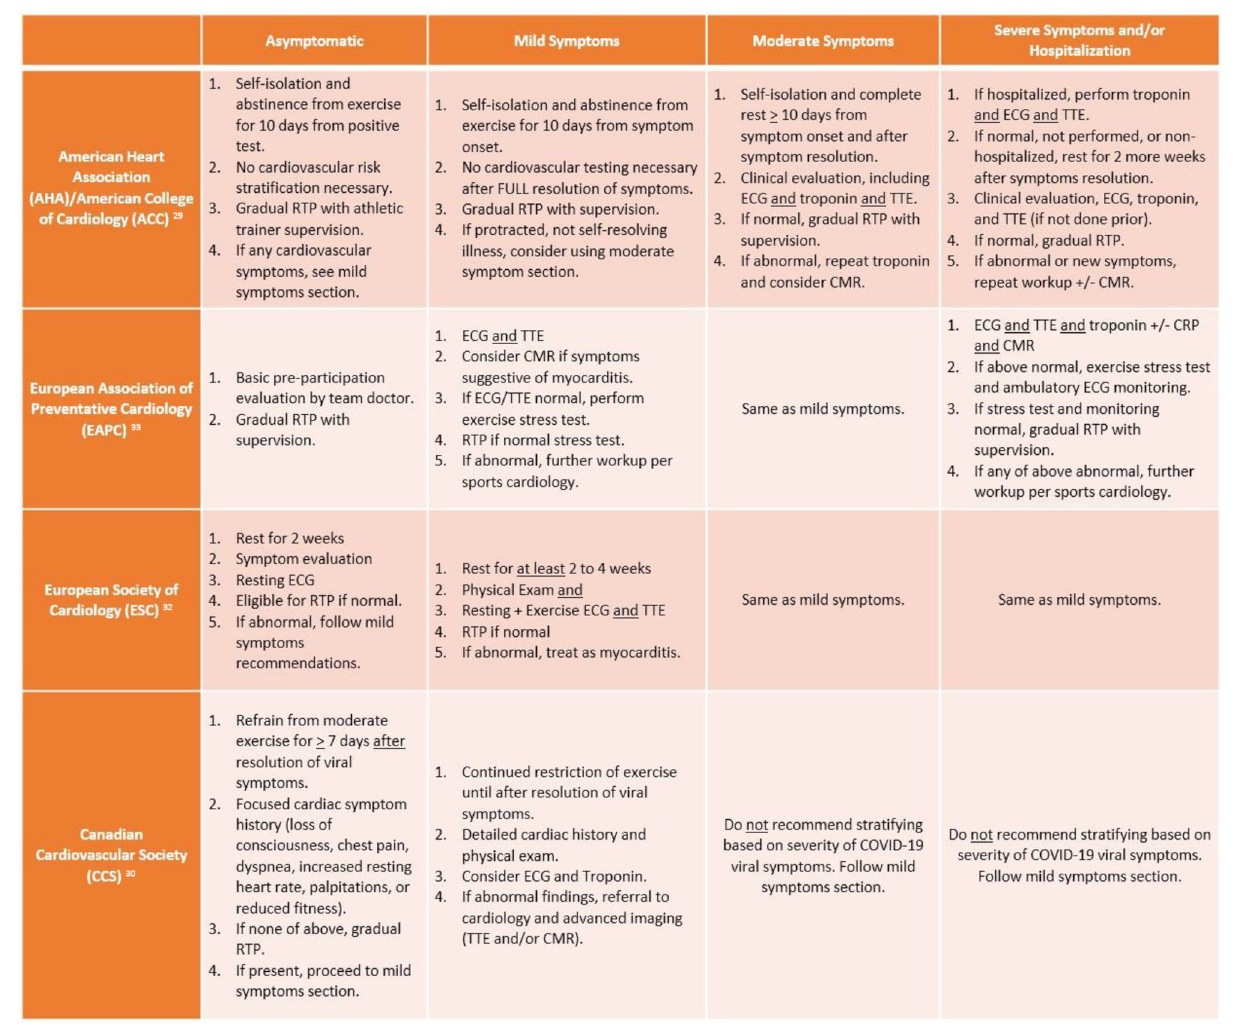
FIGURE 2 | Summary of return to play (RTP) recommendations from major cardiology societies. ECG, electrocardiogram; TTE, transthoracic echocardiogram; CMR, cardiac magnetic resonance imaging; CRP, C-reactive